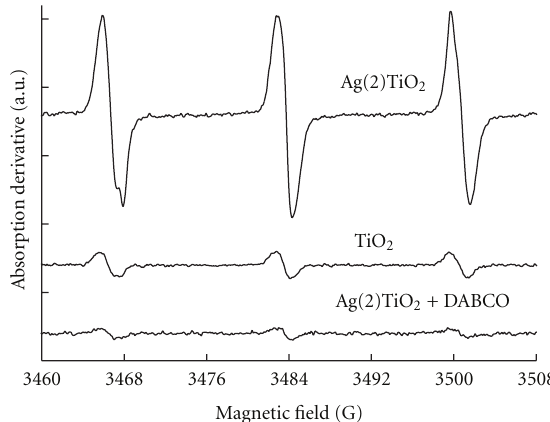
Figure 5: N 2 ( the TiO 2 and Ag(2)TiO 2 samples.